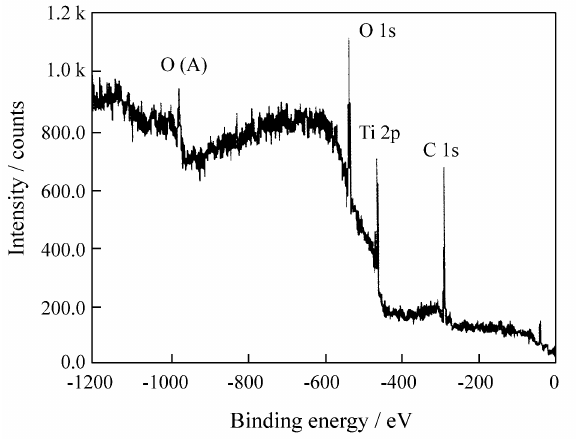
Figure 5. XPS spectrum for the as-machined